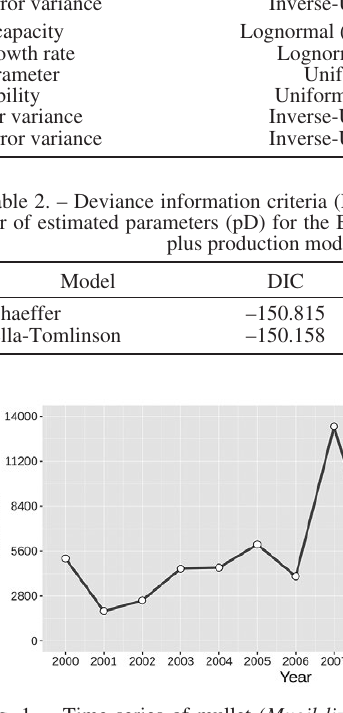
Fig. 1. – Time series of mullet ( Mugil liza ) total landings off the southeastern and southern coast of